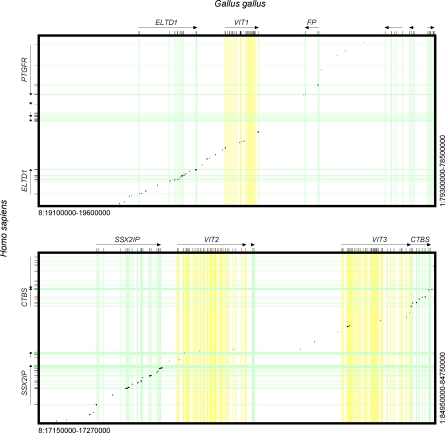
Genome Alignment (Dot Plot Representing SIM Alignments) of Human/Chicken Syntenic Regions VIT 1-VIT3 RegionsThe chain with the best cumulative score is shown. Alignment of flanking genes confirms the synteny of the aligned regions. The combined alignments of VIT1 coding sequences showed significantly higher alignment scores than the genomic background (introns and intergenic regions) in the chain, as assessed by a Mann-Whitney U test (p < 0.05). Thus, we can statistically exclude that detected VIT1 remnants from humans represent spurious sequence matches. The coding sequence matches for VIT2/3 may be too short to provide statistical significance or partially spurious.